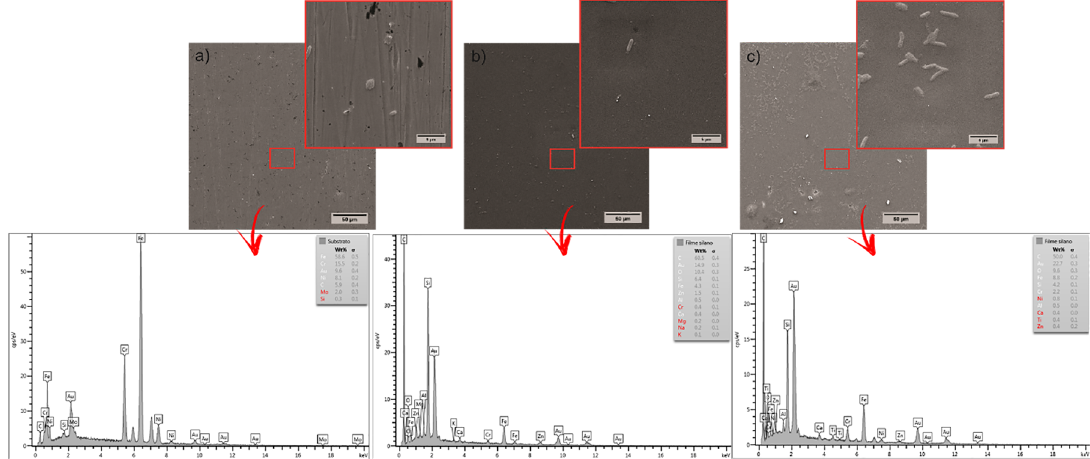
Figure 2. Top micrographs obtained through FEG-SEM for: (a) 316L, (b) 316L_1 e (c) 316L_2. Original magnification of 1000x and